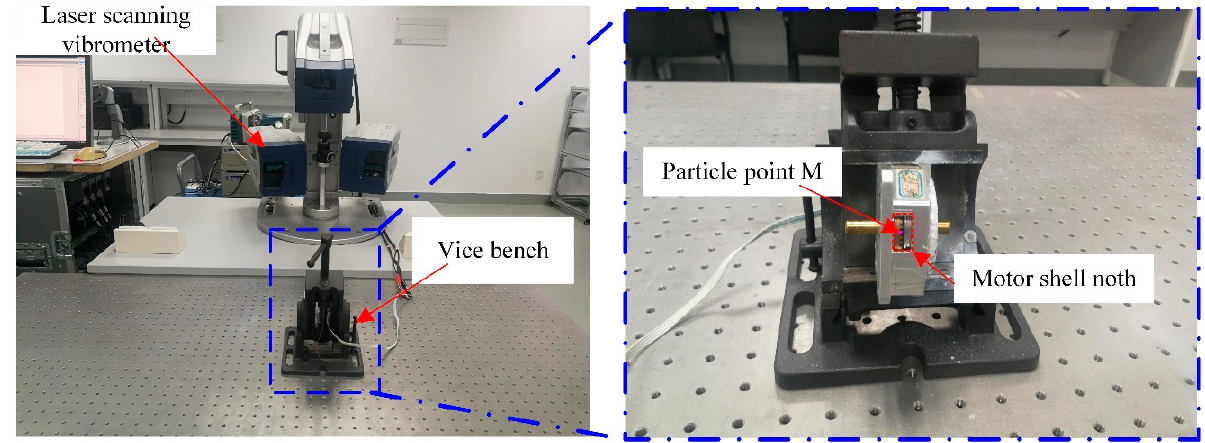
Figure 24. Tooling diagram of stator amplitude test with prepressure.